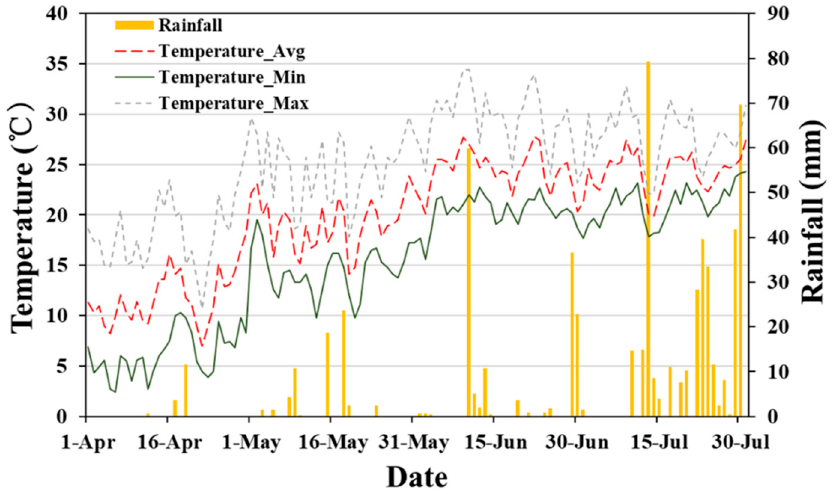
Figure 3. Precipitation and temperature variations during the 2020 corn growing season in Goesan- Figure gun.